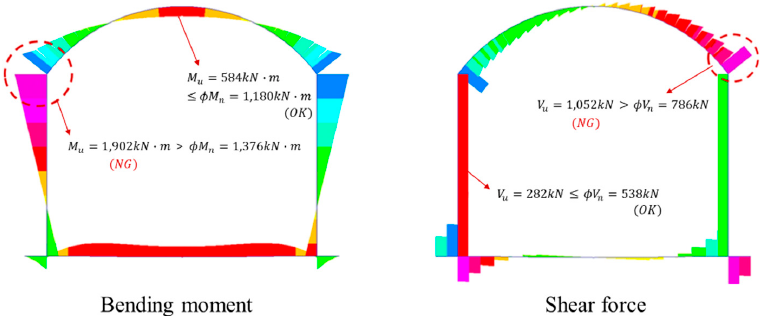
Figure 18. Bending moment and shear force distribution on the concrete lining of the central tunnel.